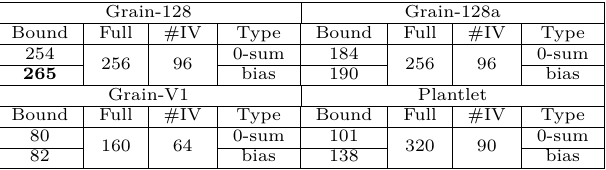
Table 5: The Upper Bounds for Grain Family Against Bias Testers